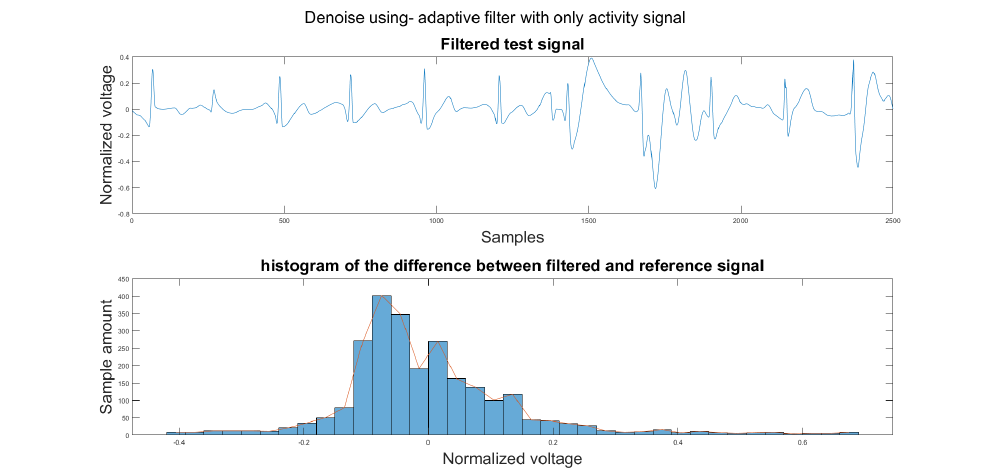
Figure A28. (1) Test signal, (2) histogram of the difference.